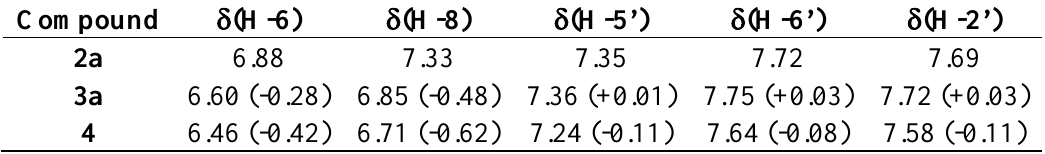
Table 1. Chemical shifts ( δ ) of the aromatic protons of pentaacetyl quercetin ( 2a ), 3,3’,4’,7-tetraacetyl quercetin ( 3a ) and 3,3’,4’,5-tetraacetyl quercetin ( 4 ) measured in CDCl . Chemical shift differences ( ∆δ ) relative to 2a are shown in 3